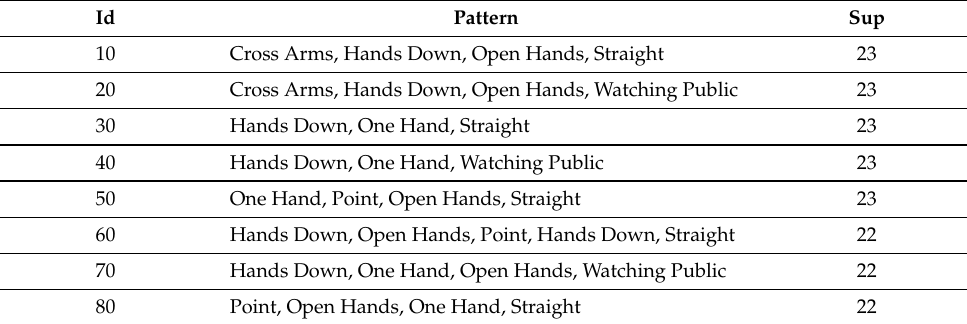
Table 7. Selected sequences from presentation 3 of